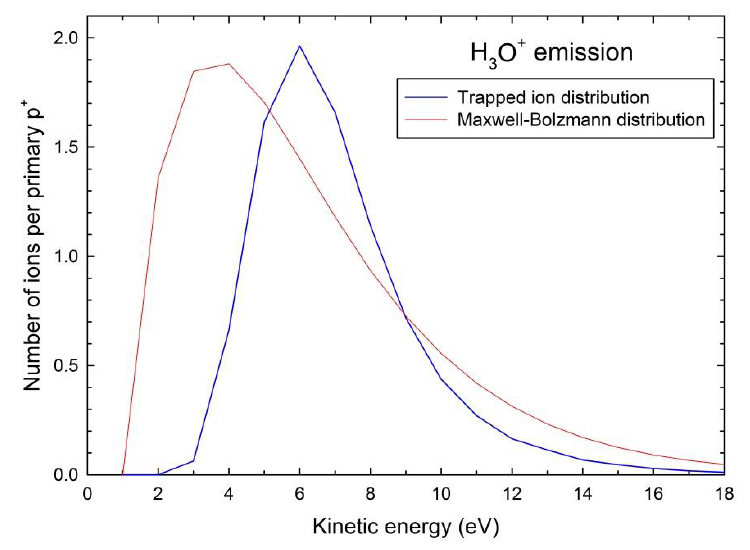
Figure 9. Kinetic energy distribution of trapped ions (blue curve). The red solid line is a Maxwell– Boltzmann statistical distribution for T = 3 × 10 4 K.